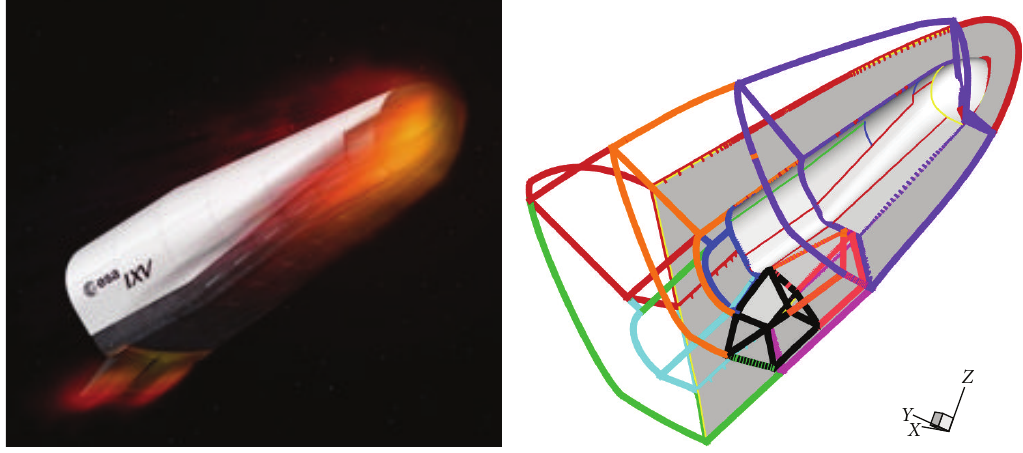
Figure 1: The ESA IXV vehicle.